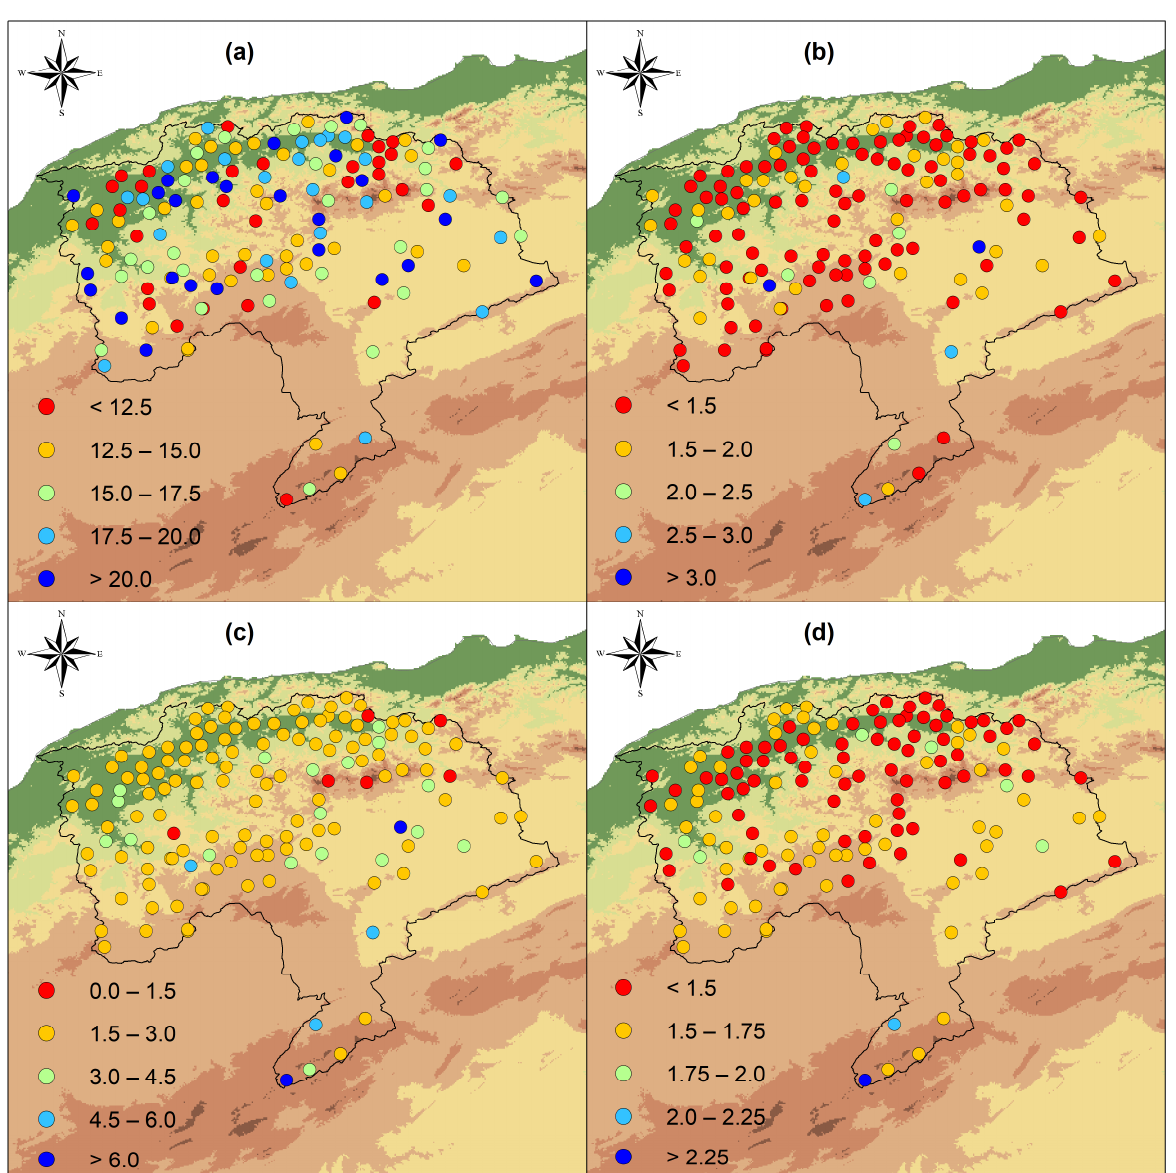
Figure 5. Spatial distribution of the ( a ) wet frequency in %, ( b ) average wet duration in years, ( c ) average wet severity and ( d ) average wet intensity in year −1 .